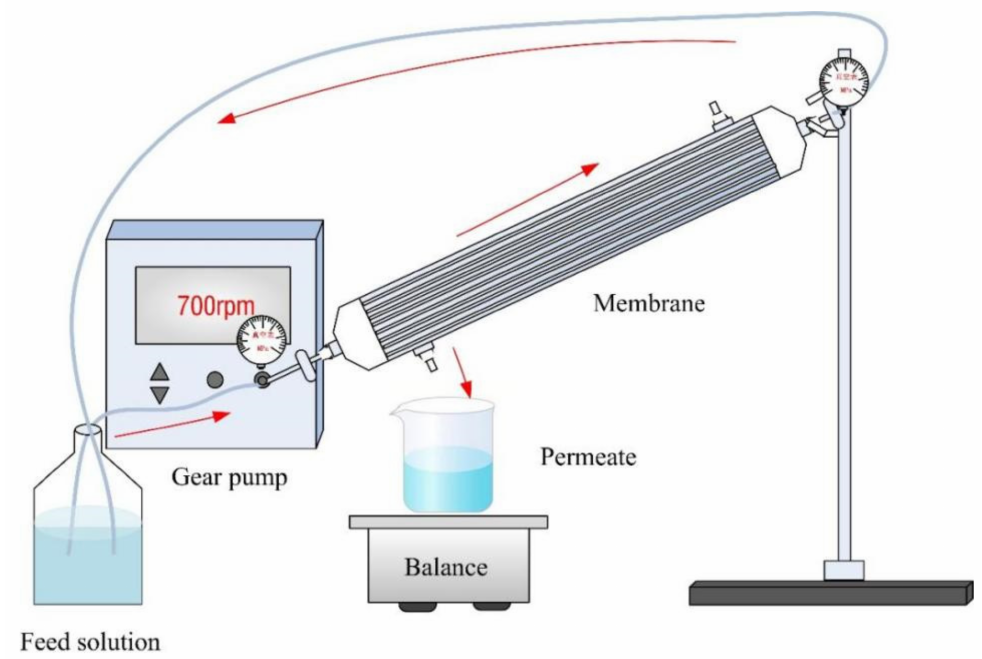
Figure 2. The cross-flow filtration